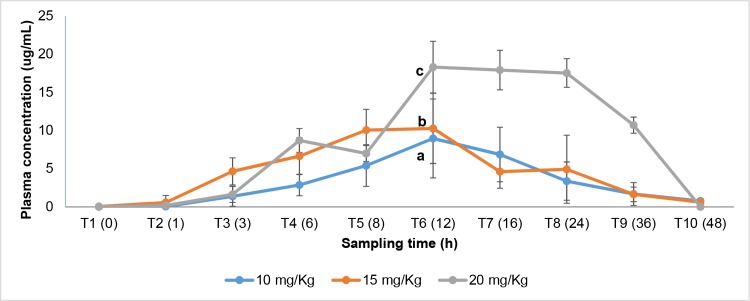
Average plasma concentrations (μg/mL) by sampling time (hours) and dose: 10, 15 and 20 mg/Kg.Different letters represent statistical differences between groups (p<0.05).